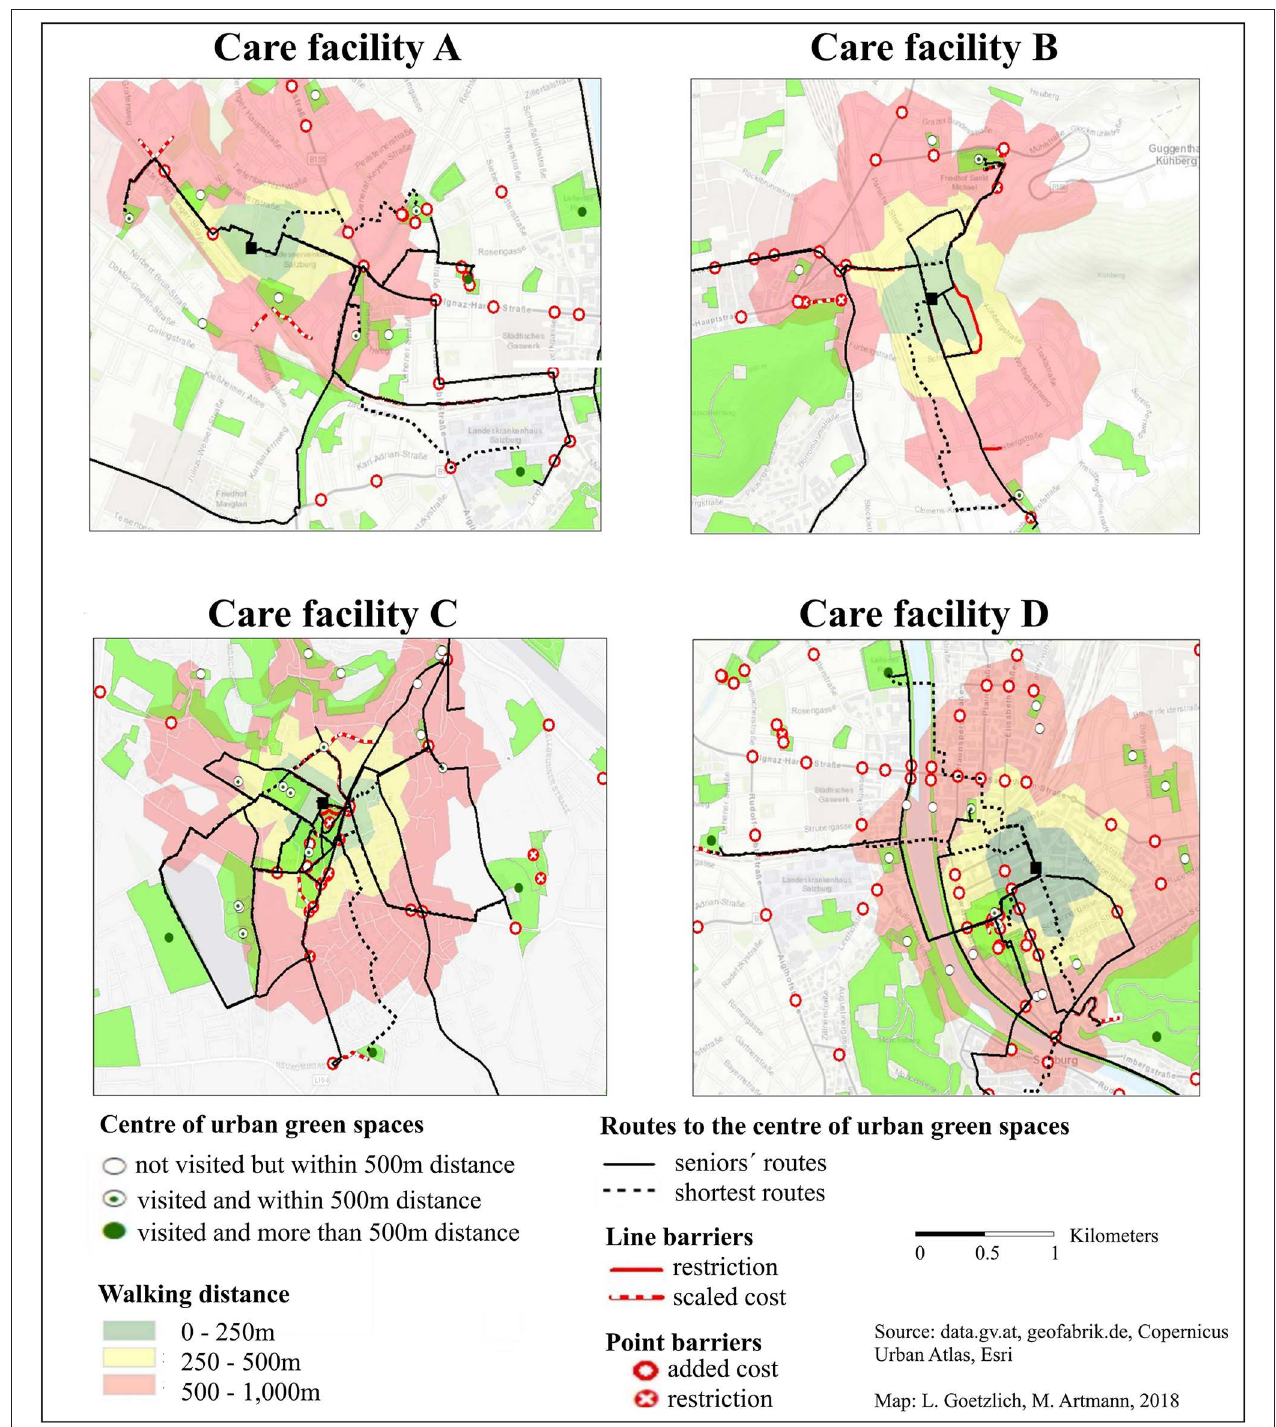
FIGURE 3 | Routes with barriers and walking distances to urban green spaces.